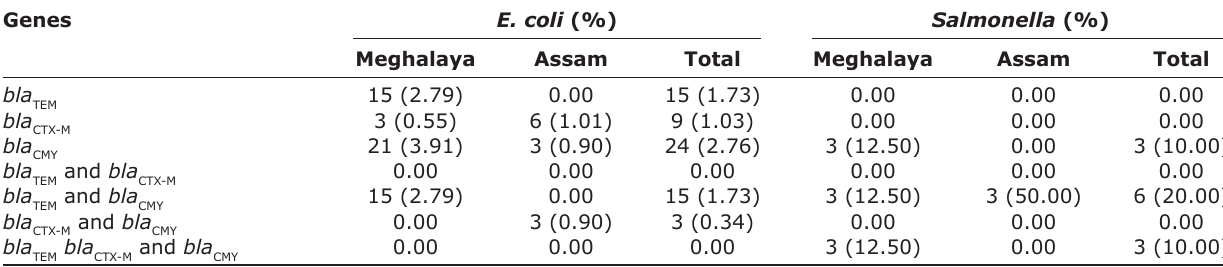
, bla , and bla ) in E. coli and Salmonella spp. Isolated form pigs in TEM CTX-M CMY